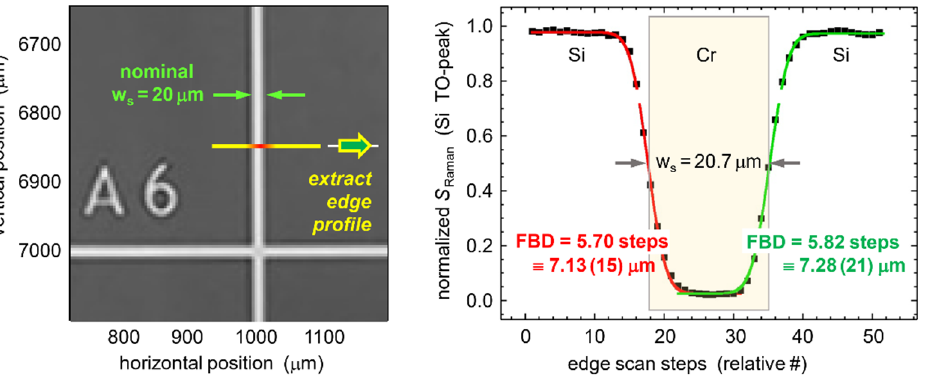
Figure 4. Determination of the laser focal beam diameter (= FBD) on the target surface, through the ×10 microscope objective. Line-scan for the focused laser beam across a chromium grid line of a silicon SEM-finder grid substrate (EM-Tec FG1, Micro to Nano ), using the edge-scan method [25]; the scan data are for the 2TO spectral line of silicon. For details, see text.